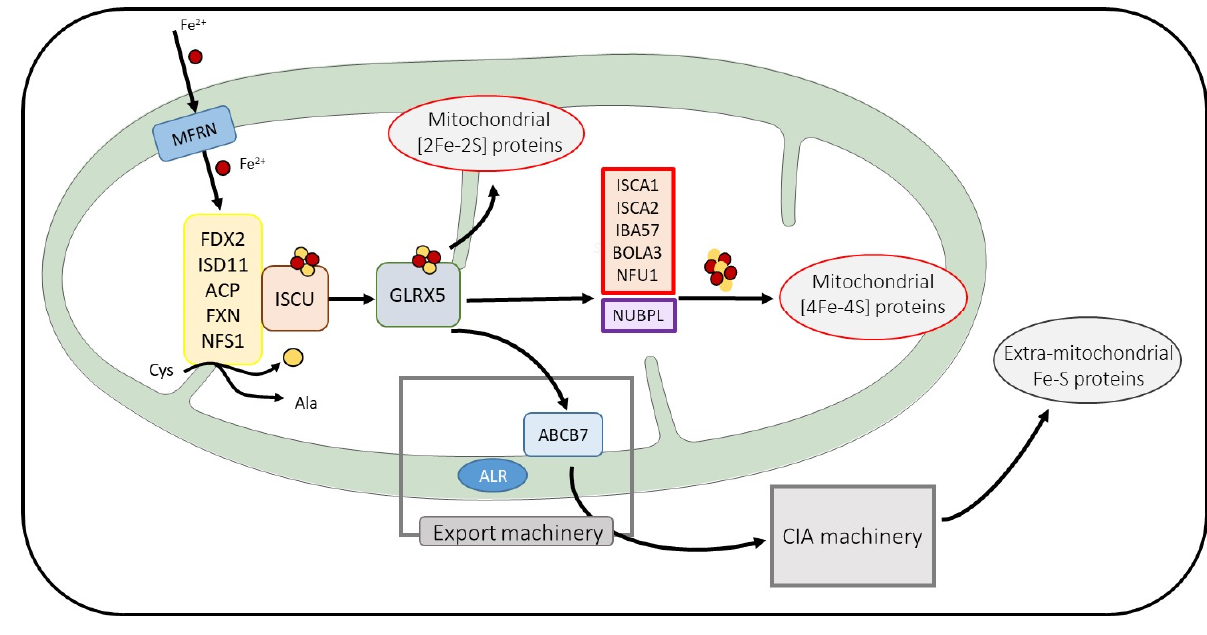
Figure 1. Schema of the main steps of Fe-S protein maturation. Only the mitochondrial ISC machinery components are detailed. Mitoferrin (MFRN) is involved in iron entry in mitochondria. Proteins in yellow frames are needed for cysteine desulfuration and [2Fe-2S] cluster de novo assembly on the ISCU. After its transfer on GLRX5, the [2Fe-2S] cluster is exported to the cytosol (for extra-mitochondrial Fe-S protein maturation) and is inserted to mitochondrial [2Fe-2S] proteins or is taken in charge by proteins essential for [4Fe-4S] cluster biosynthesis and the maturation of mitochondrial [4Fe-4S] containing proteins. Proteins involved in MMDS pathologies are framed in red.